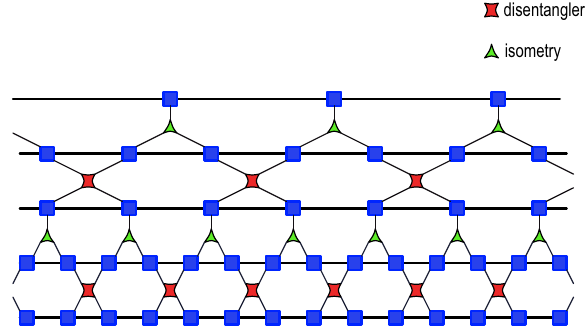
disentangler isometry